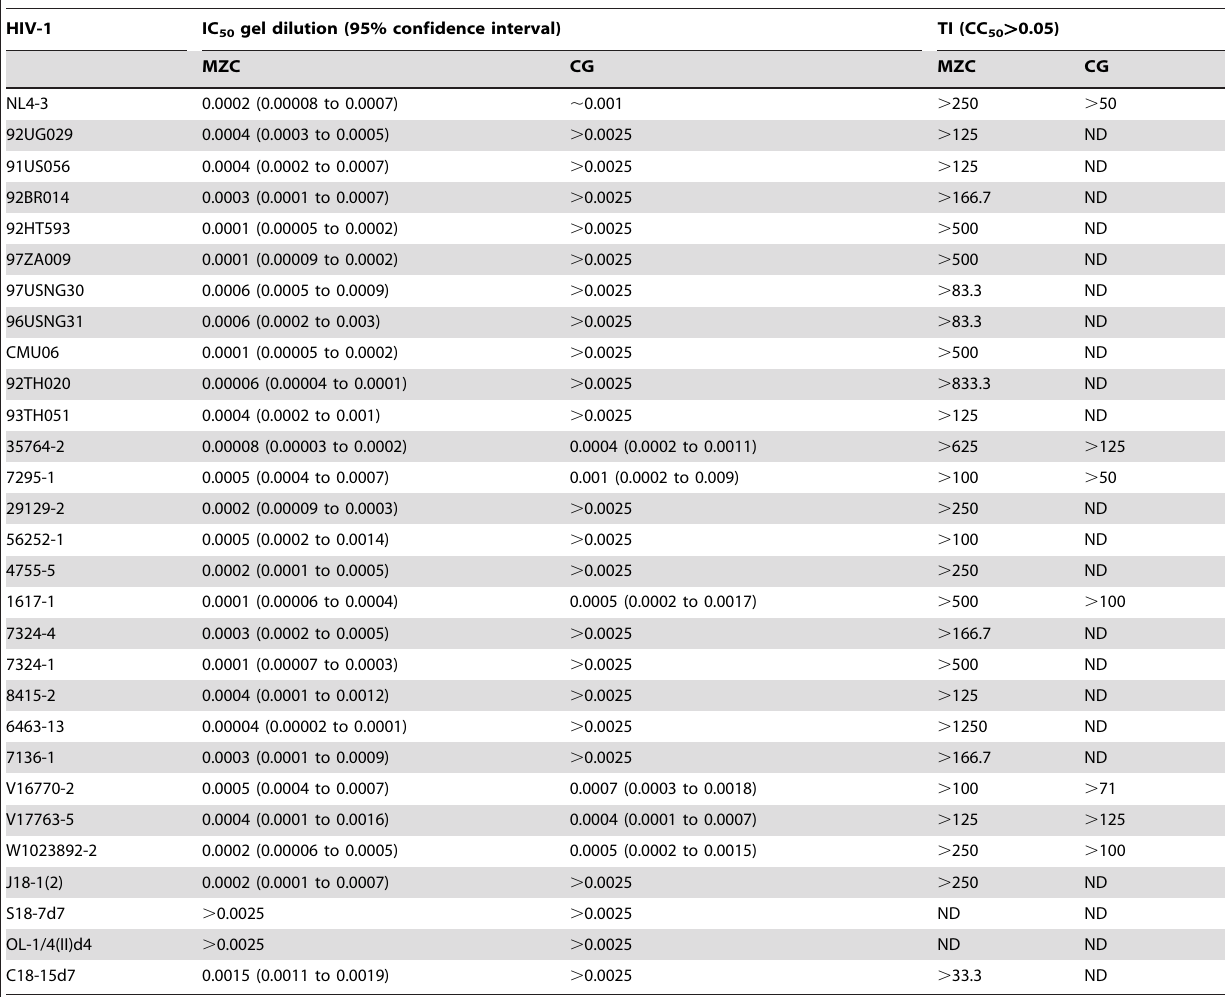
Table 2. Antiviral Activity of MZC and CG against HIV-1 in PBMCs.